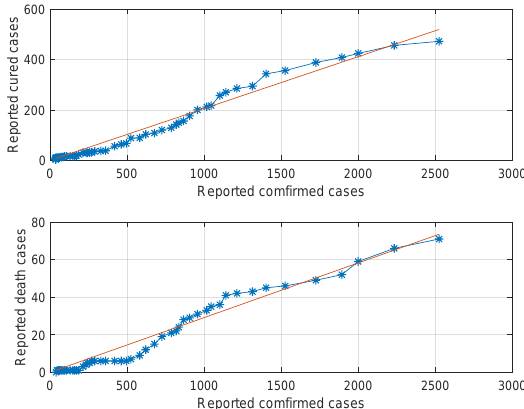
Figure 2. The reported cured and death cases of the reported confirmed